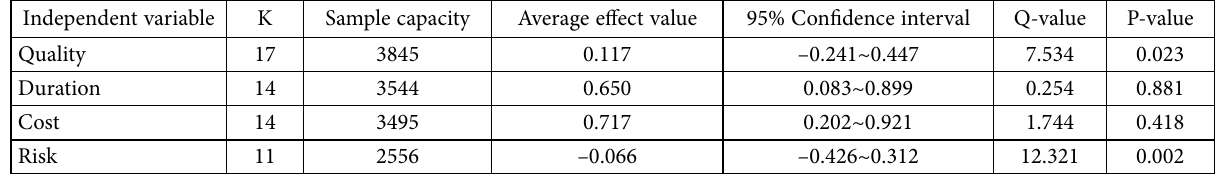
Table 5. Regulatory effect of engineering type on engineering harmony affected by quality, duration, cost and